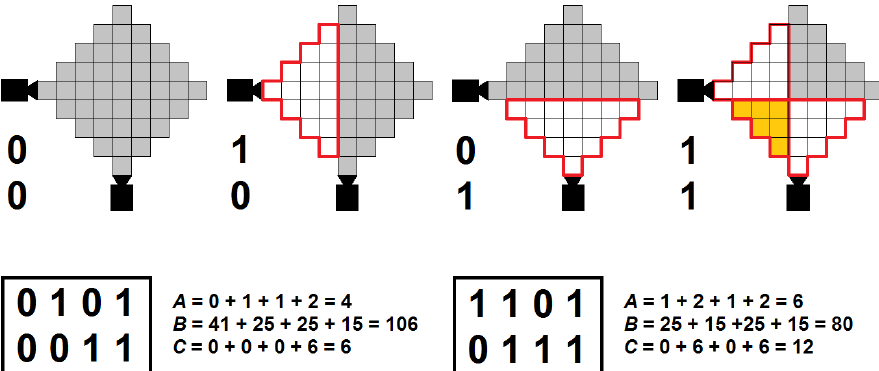
Figure 1. Schedule encoding scheme and evaluation of the input variables to the fitness function, for a two-cameras example (two rows) and a four steps periodic time-window (four